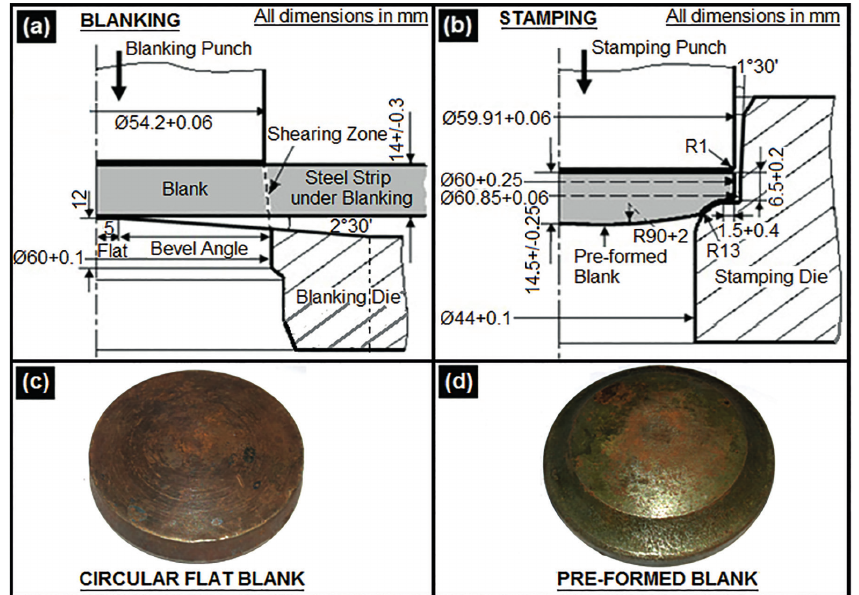
Figure 3: Schematically showing of arrangements, a) blanking operation, and c) stamping operation; Photo images, b) circular flat blank, and d) preformed blank.